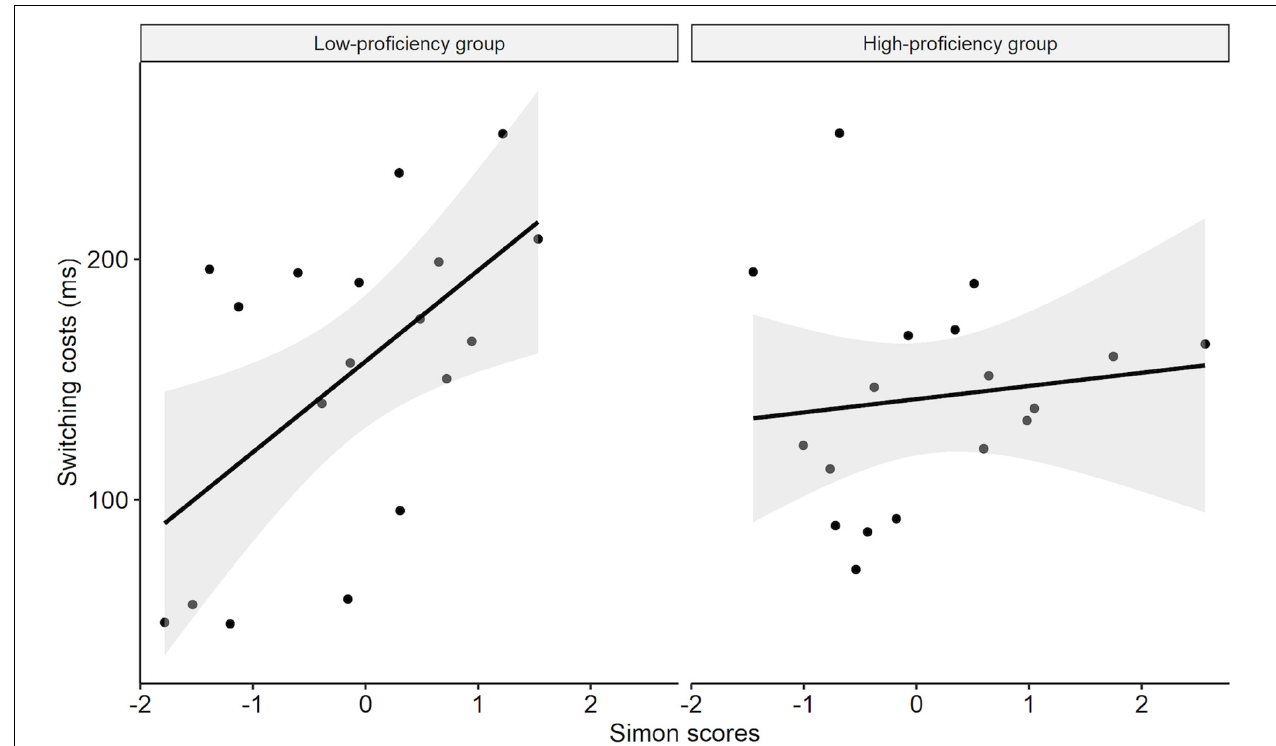
FIGURE 1 | Relationship between inhibitory control and the switching cost modulated by OPT